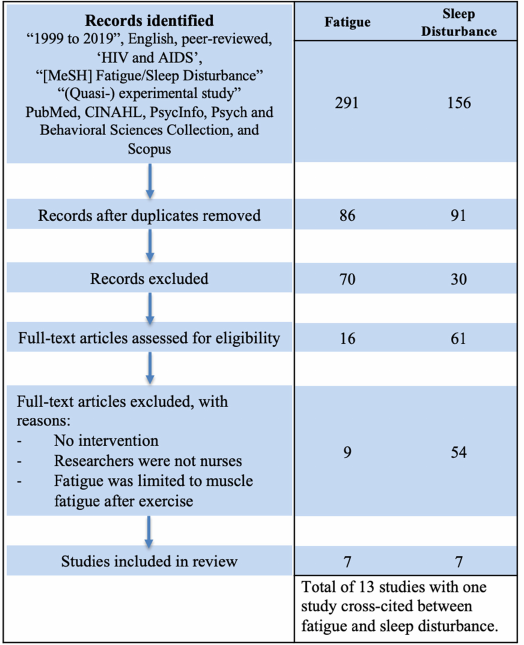
Figure 1. PRISMA Flowchart.